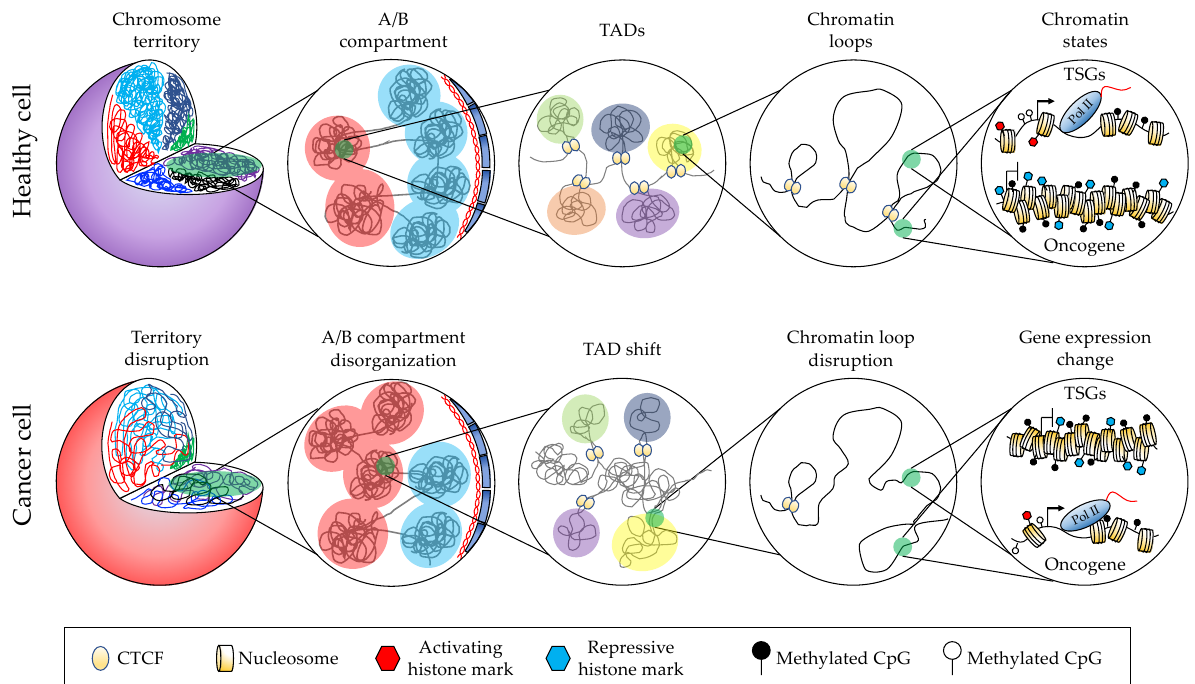
Figure 1. The hierarchical levels of genome organization and how they are modified in cancer